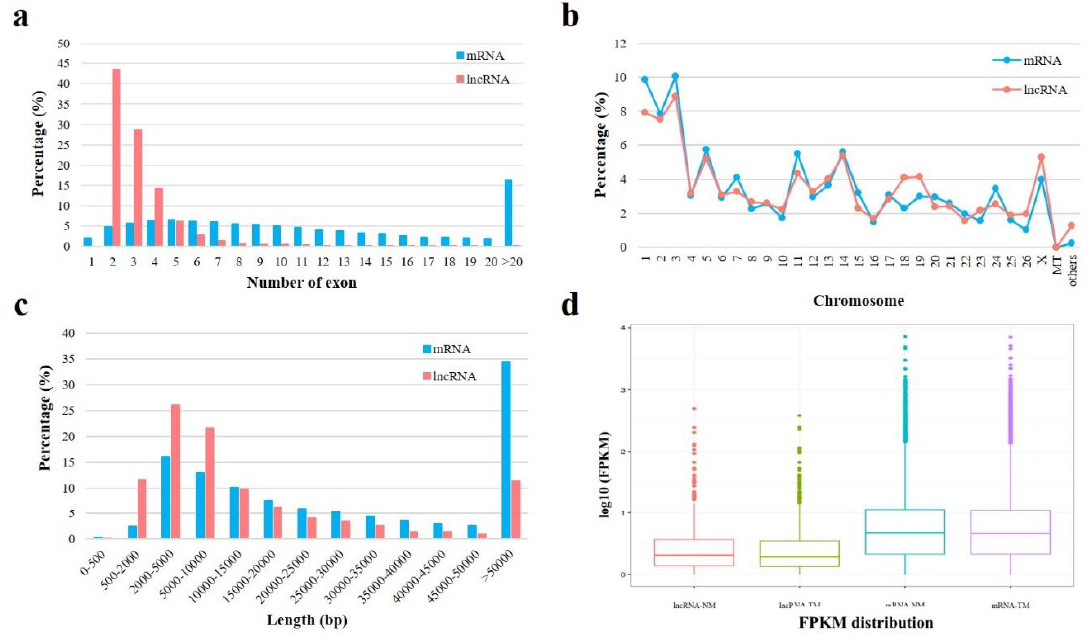
Figure 3. Comparison analysis of lncRNAs and mRNAs in sheep pituitary. ( a ) The statistics on the number of exon in lncRNAs and mRNAs. ( b ) The chromosome distribution of lncRNAs and mRNAs. ( c ) The length comparison of lncRNAs and mRNAs. ( d ) The boxplot shows the average expression levels (log10 (FPKM)) of lncRNAs and mRNAs in TM and NM groups.